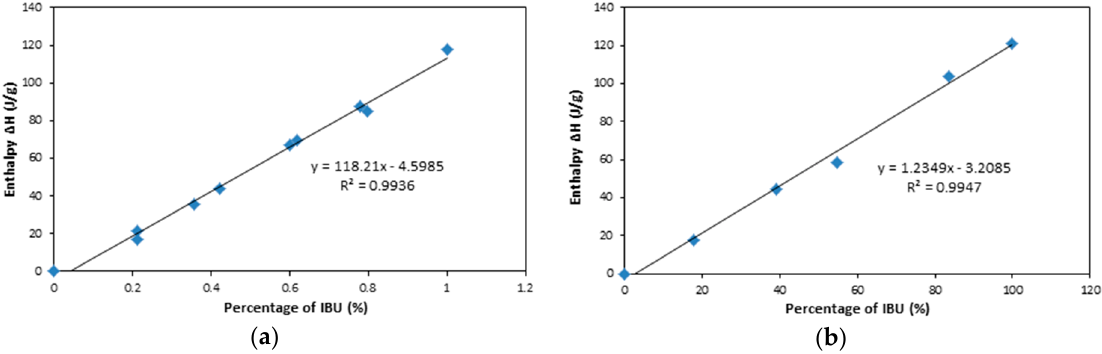
Figure 7. Relationship of the enthalpy and the percentage of IBU mixed with ( a ) S244FP and ( b ) NS2. Table 2. Comparison of the predicted and actual concentrations.